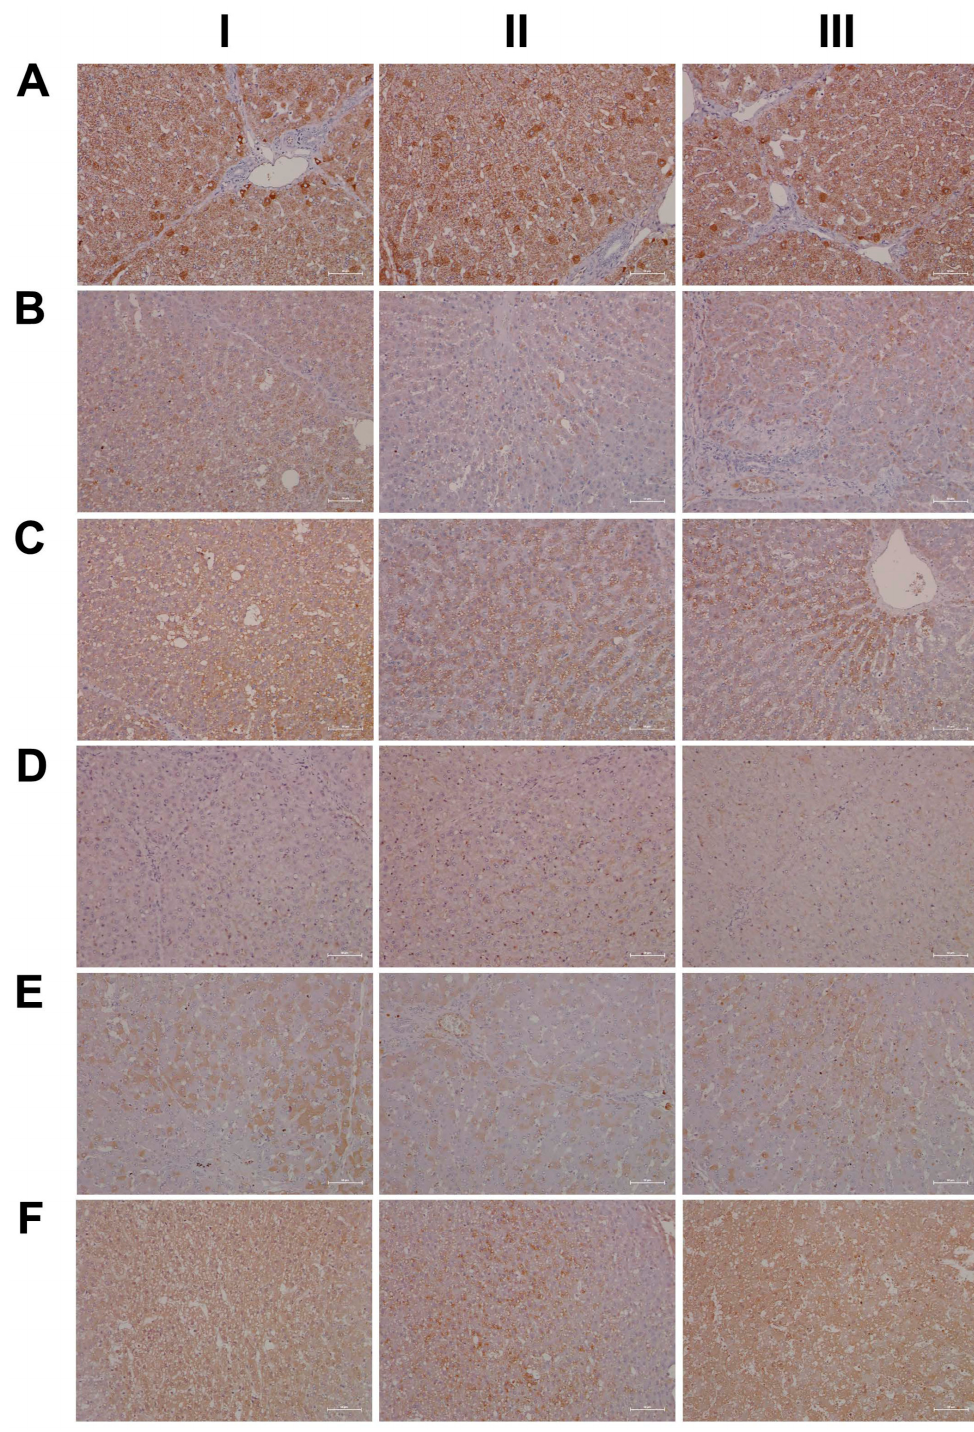
Figure 3. Immunohistochemistry of carbamoyl-phosphate synthetase 1 (CPS1) and ELOVL fatty acid elongase 2 (ELOVL2) in liver sections of control and diclofenac-treated animals after daily dosing for 28 days. CPS is a key enzyme in the urea cycle and catalyzes the rate-limiting step in the detoxification of ammonia and ELOVL2 functions in lipid metabolism and PUFA elongation, thereby reducing the production of inflammatory lipids. Panel AI–III : CPS1 staining of three individual control animals. All hepatocytes express CPS1; however, some express the protein more abundantly. Panel BI–III : CPS1 staining of three low-dose-treated animals. Diclofenac treatment caused